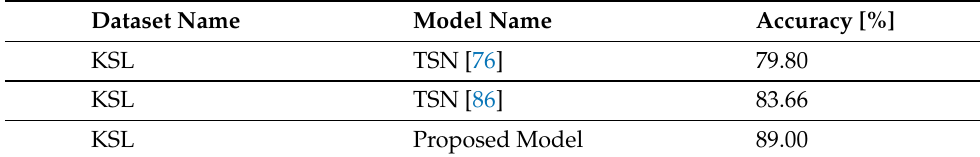
Table 2. Comparison of the state-of-the-art model for the KSL